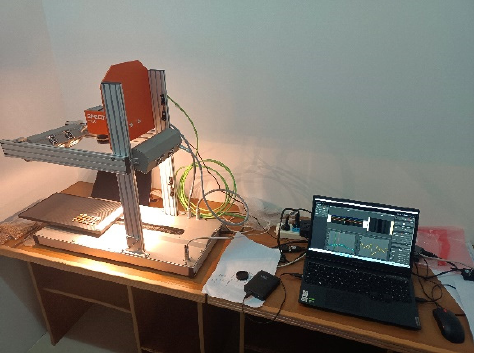
Figure 1. The hyperspectral image data acquisition system of corn kernel